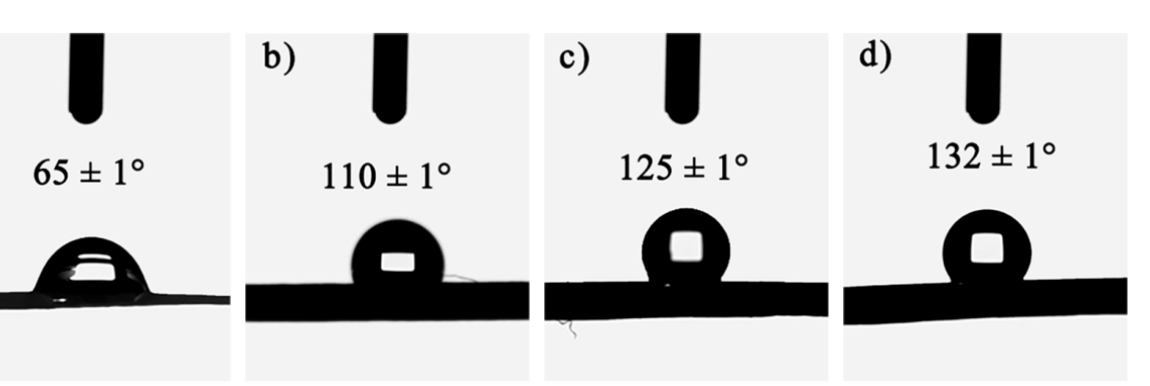
Figure 3. Wettability of CAF-1 ( a ), CAF-2 ( b ), CAF-3 ( c ), and CAF-4 ( d ). (The sample number is shown in Table 1). Table 1. Physical properties of CAFs.